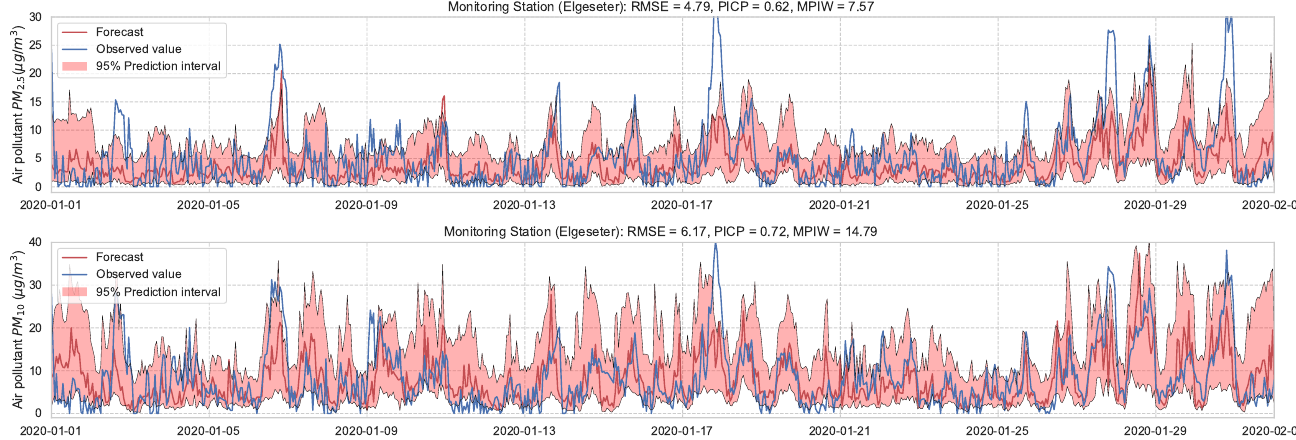
Figure 8. Air quality prediction interval using quantile regression of a Gradient Tree Boosting